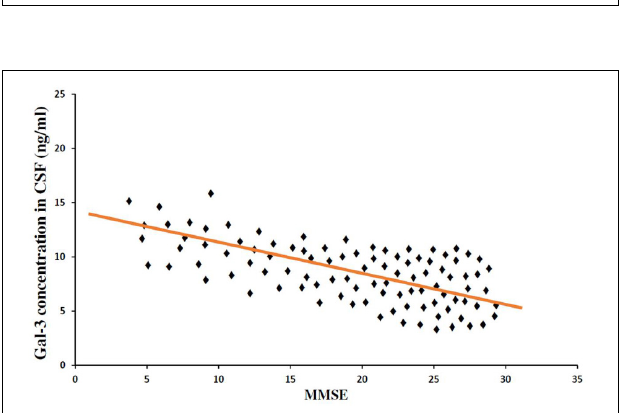
FIGURE 5 | Mini Mental Status Examination (MMSE) and serum Gal-3 concentrations. A significant correlation was observed between MMSE score as a measure of cognitive status and serum Gal-3 levels ( P = 0.306; P < 0.001) in all the patients (AD = 31, ALS = 19, Controls = 50).